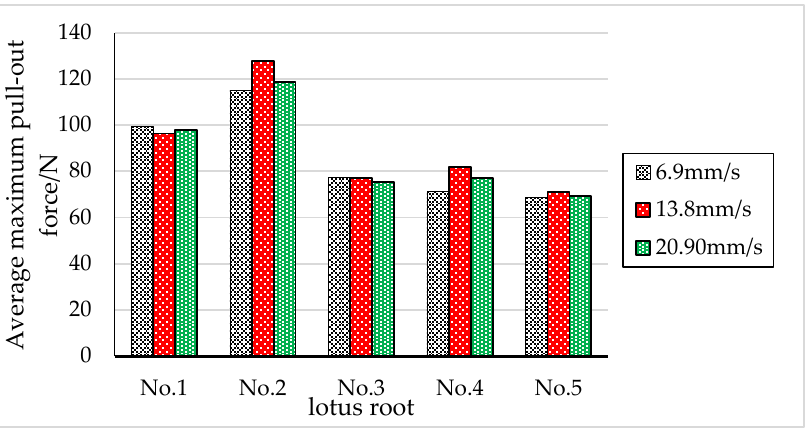
Figure 11. Average maximum pull-out force of different lotus roots at the burial depth of 15 cm.